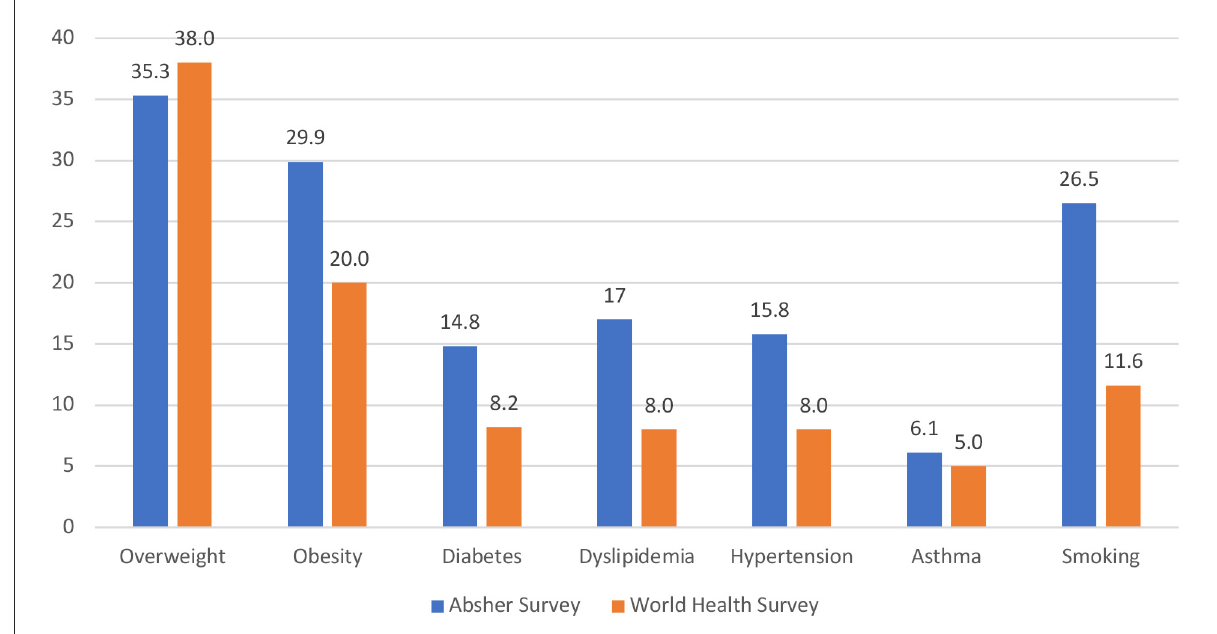
FIGURE1 Difference in prevalence rates (%) of selected self-reported diseases and risk factors between the Absher Survey 2019–2020 and World Health Survey